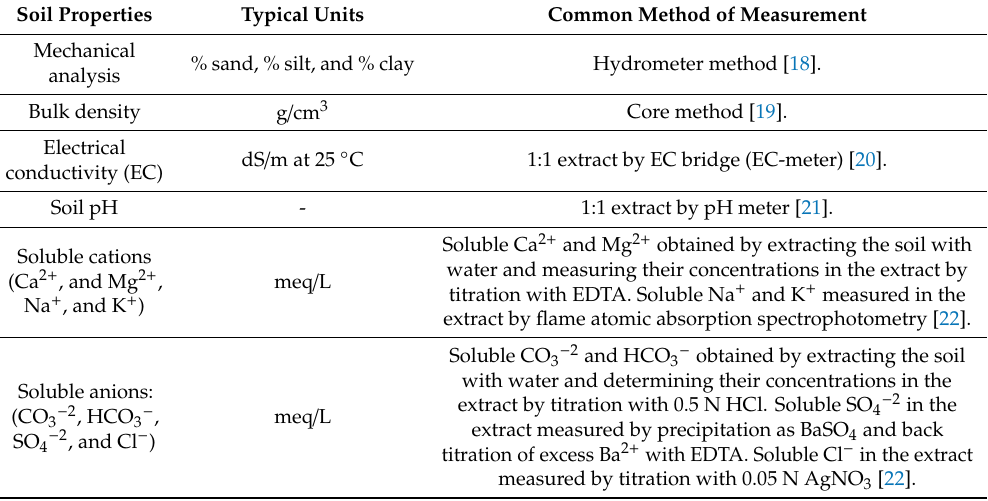
Table 5. Typical soil properties from the soil databases of